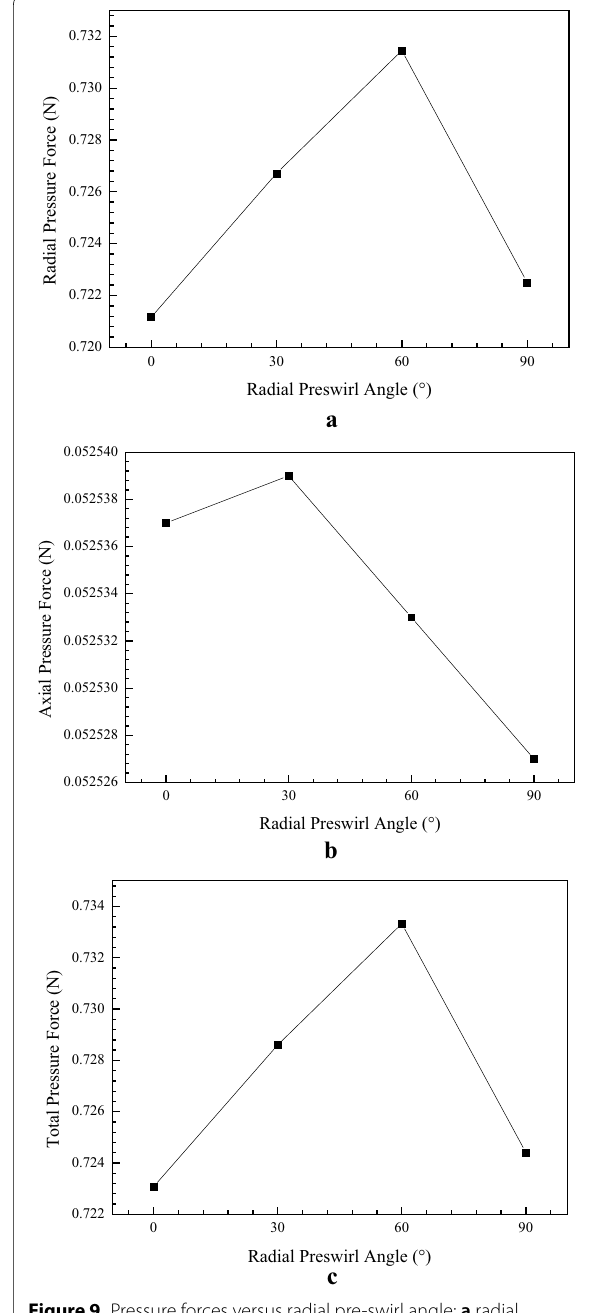
Figure 9 Pressure forces versus radial pre-swirl angle: a radial pressure force; b axial pressure force; c total pressure